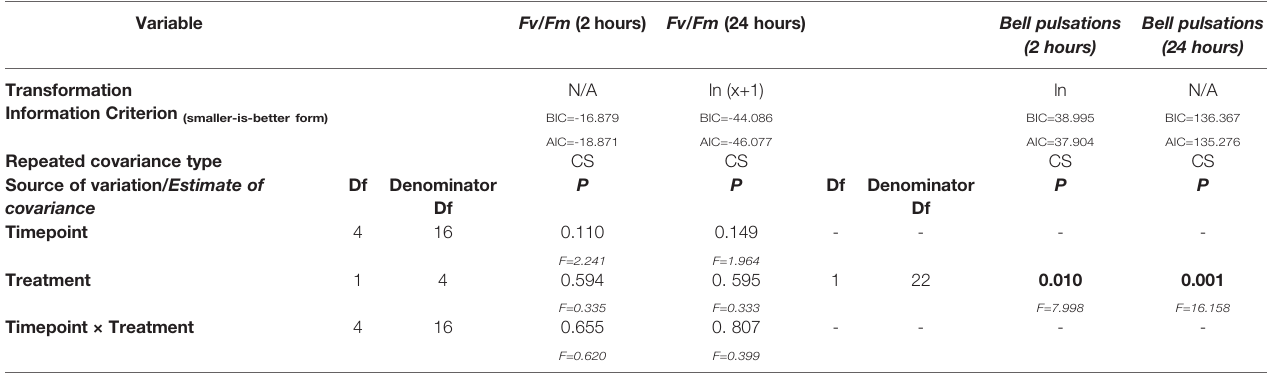
TABLE 2 | Summary of results for Linear Mixed Models (LMMs) conducted on the investigated biological responses of Cassiopea jelly fi sh during the exposure to Magnesium Chloride